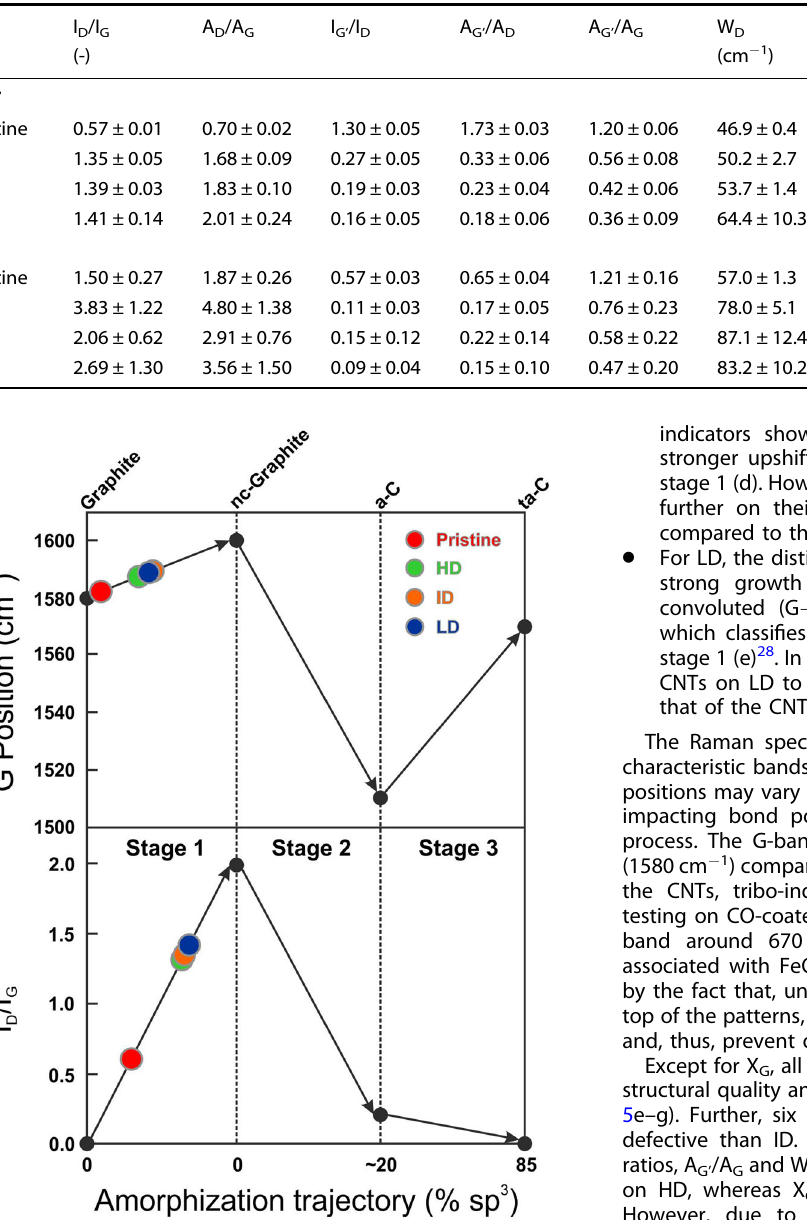
Fig. 4 Carbon amorphization trajectory according to Ferrari and Robertson, including data of the characterized CNTs (adapted from ref. 23 ). It shows a schematic variation of the G-band position and I D /I G (obtained with 514 nm) depending on crystallinity as well as sp 2 /sp 3 content of the